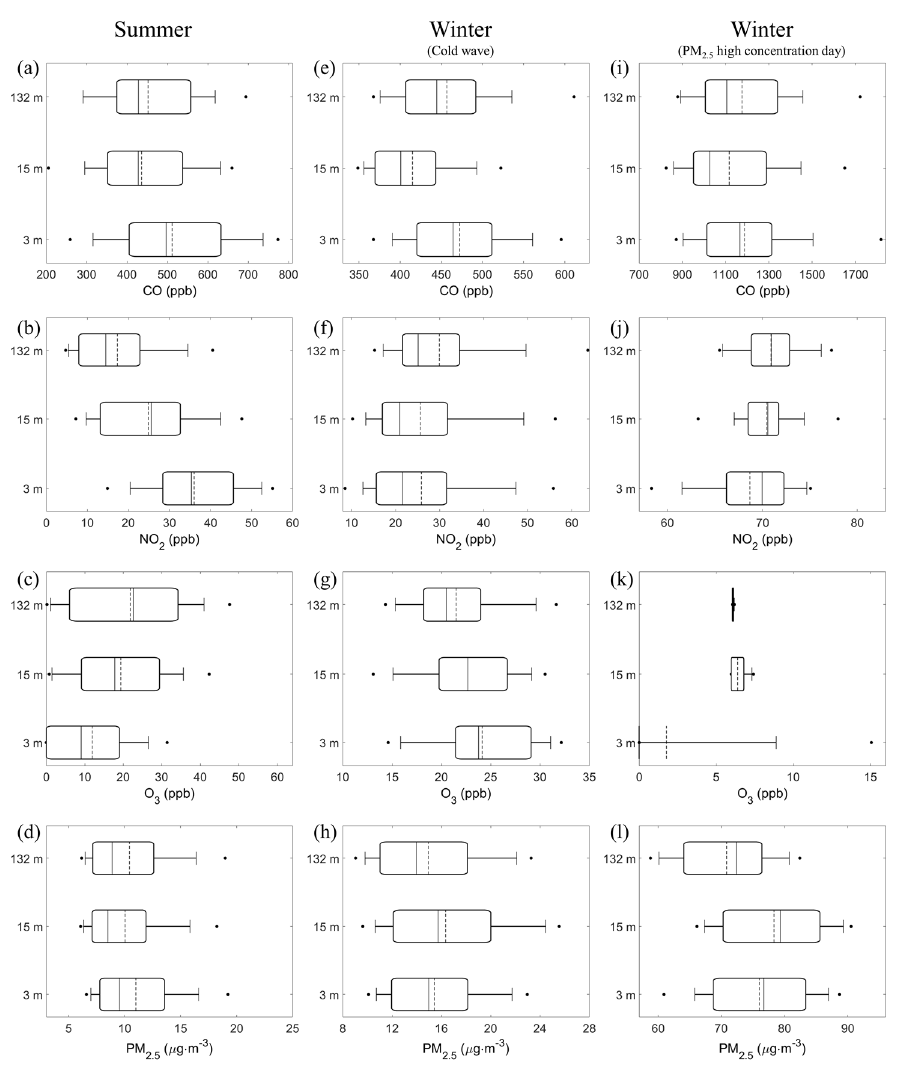
Figure 7. Horizontal box plots of the vertical distributions of pollutants at Site-1. The vertical dotted line in the box represents the mean value. ( a – d ): summer, ( e – h ): cold wave period of winter, and ( i – l ): the PM 2.5 pollution event. Ozone data were used only for the period of 11:00–17:00.